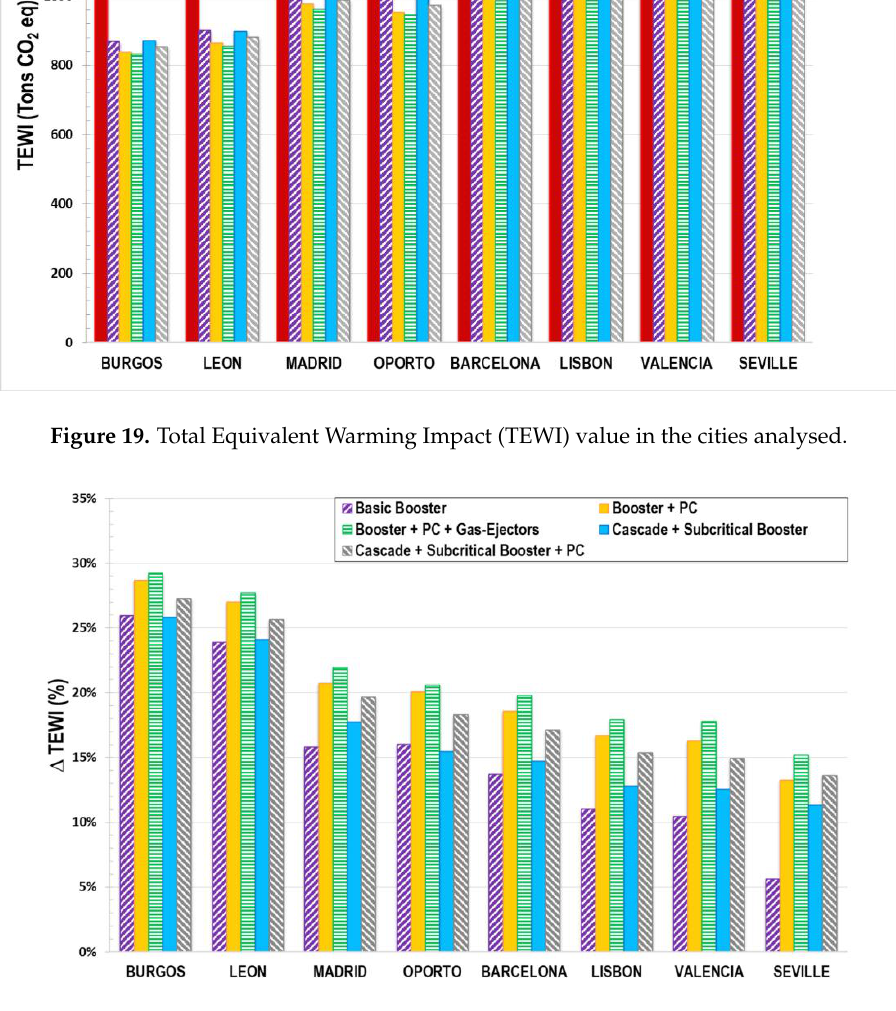
Figure 20. TEWI reductions with respect to R513A/R744 CC.